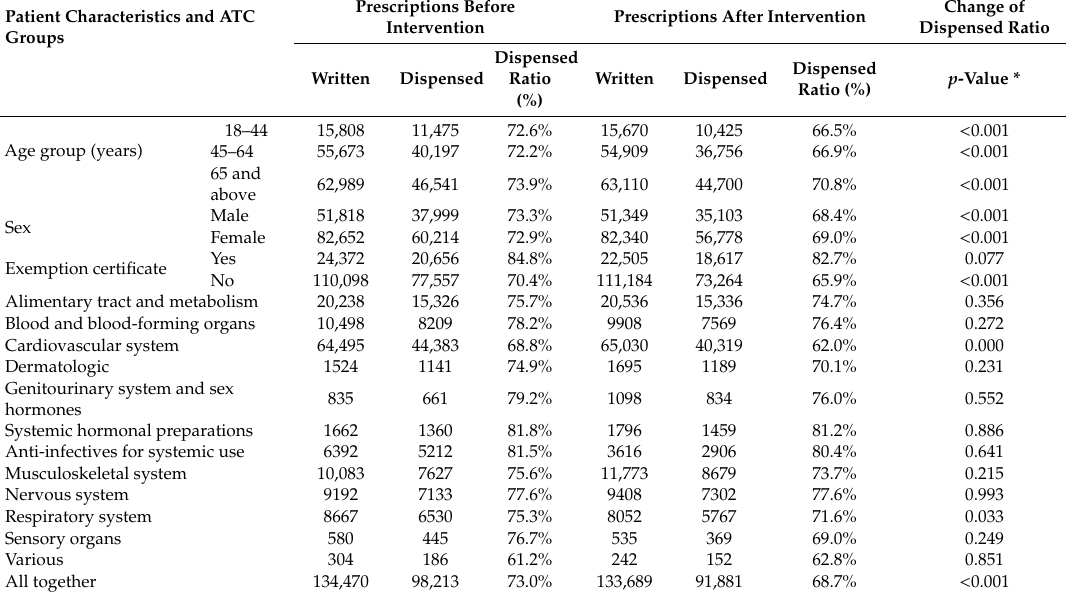
Table 3. The proportion of dispensed medications prescribed by GPs in the intervention area before and after the program implementation by patient sociodemographic characteristic and ATC drug